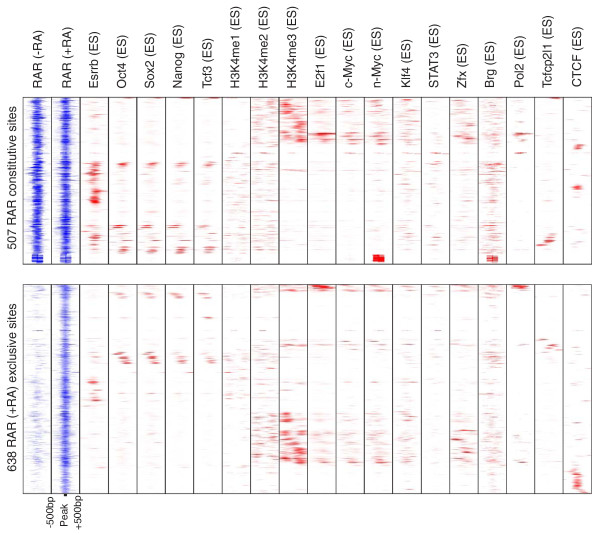
Both constitutively bound and exclusively post-RA RAR binding sites are coincident with ES cell regulatory events. Line-plot clustergram of ChIP-seq enrichment in 1-kbp windows centered on 1,924 post-RA RAR binding sites. Color shading denotes scaled ChIP-seq read depth (see Materials and methods).